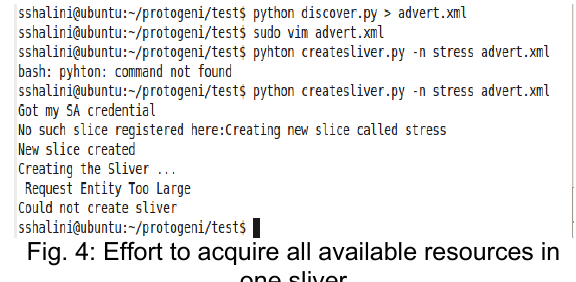
Fig. 4: Effort to acquire all available resources in one